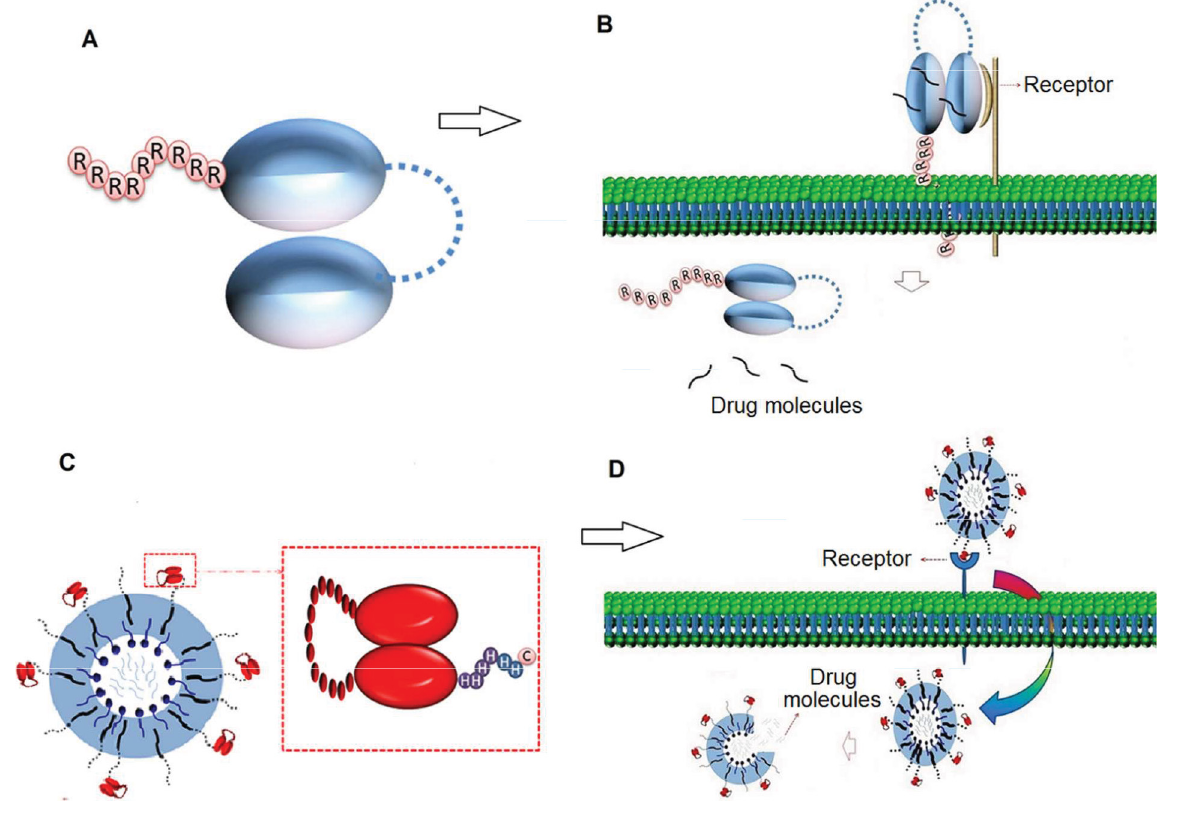
Figure 1. Structure and action mechanism of scFv-arginine fusion peptide and scFv-based immunoliposome (IL). (A) Nine arginine res- idues act as a cell-penetrating peptide, which help the fusion peptide enter the cell. (B) Fusion peptide binds to a specific receptor on the target cell by its scFv moiety and enters the cell by its C-terminal tail arginine resides. (C) Cysteine residue at the C-terminal end allows the scFv to form a covalent bond with PEG–PLA nanoparticles to create IL. (D) IL binds to the target cell through its scFv, becomes internalized into the cell and releases the encapsulated